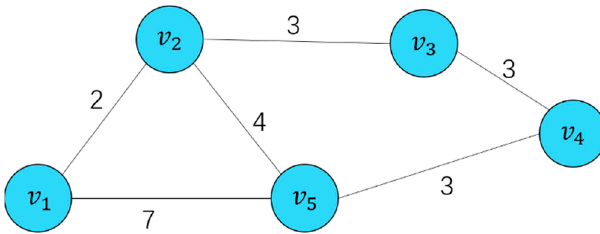
Figure 1. An example of undirected road network graph.